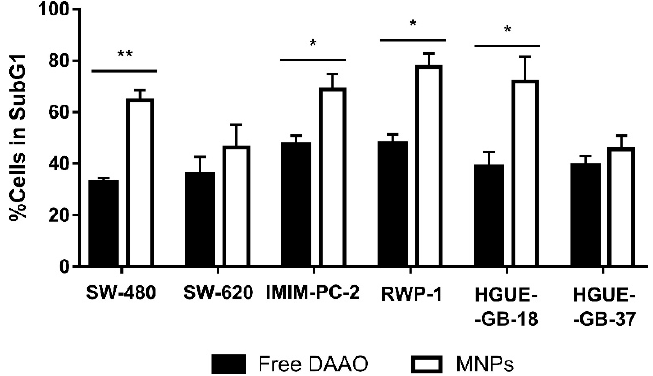
Figure 4. SW-480 and SW-620 colon carcinoma cell lines, IMIM-PC-2 and RWP-1 pancreatic adenocarcinoma cell lines, and HGUE-GB-18 and HGUE-GB-37 glioblastoma cell lines were treated with 2 U mL − 1 free or bound to magnetic nanoparticles (MNPs) CLytA-DAAO, and 1 mM D-Ala for 24 h and cell cycle distribution was determined by flow cytometry. Data represent the mean ± SEM of the percentages of treated cells in SubG1 phase minus those of the control cells with n ≥ 3. * indicates p < 0.05 and ** p < 0.01.